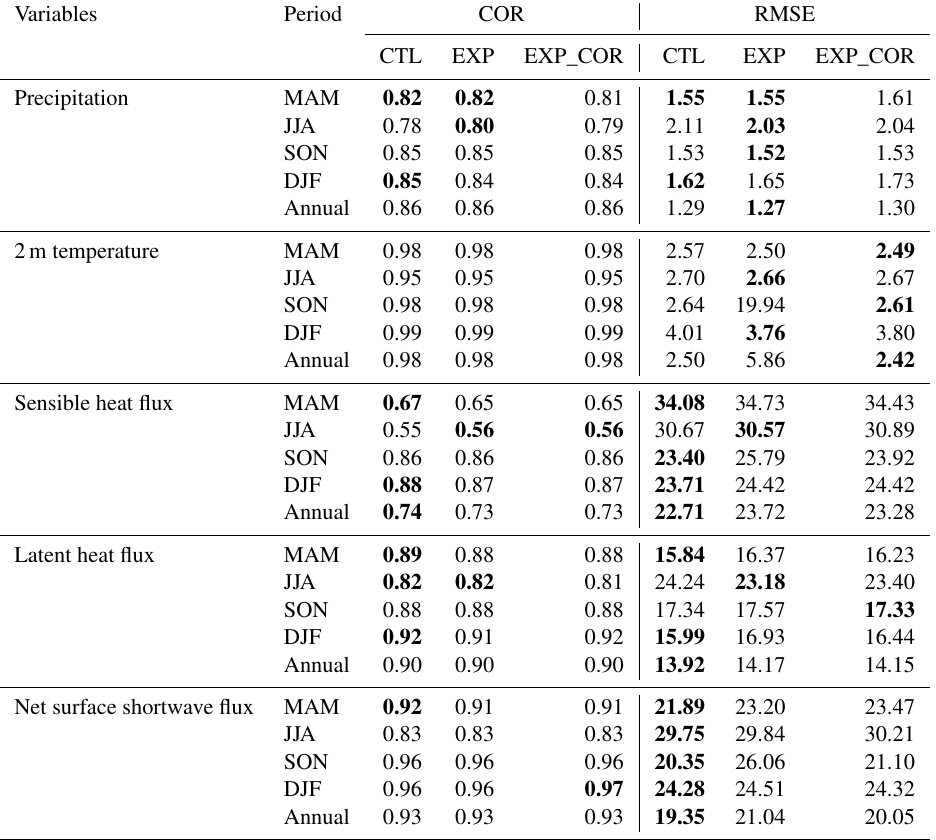
Table 1. The COR and RMSE values in the CTL, EXP and EXP_COR runs. MAM is for March–April–May, JJA is for June–July–August, SON is for September–October–November, and DJF is for December–January–February. The best performance among the three experiments is highlighted in